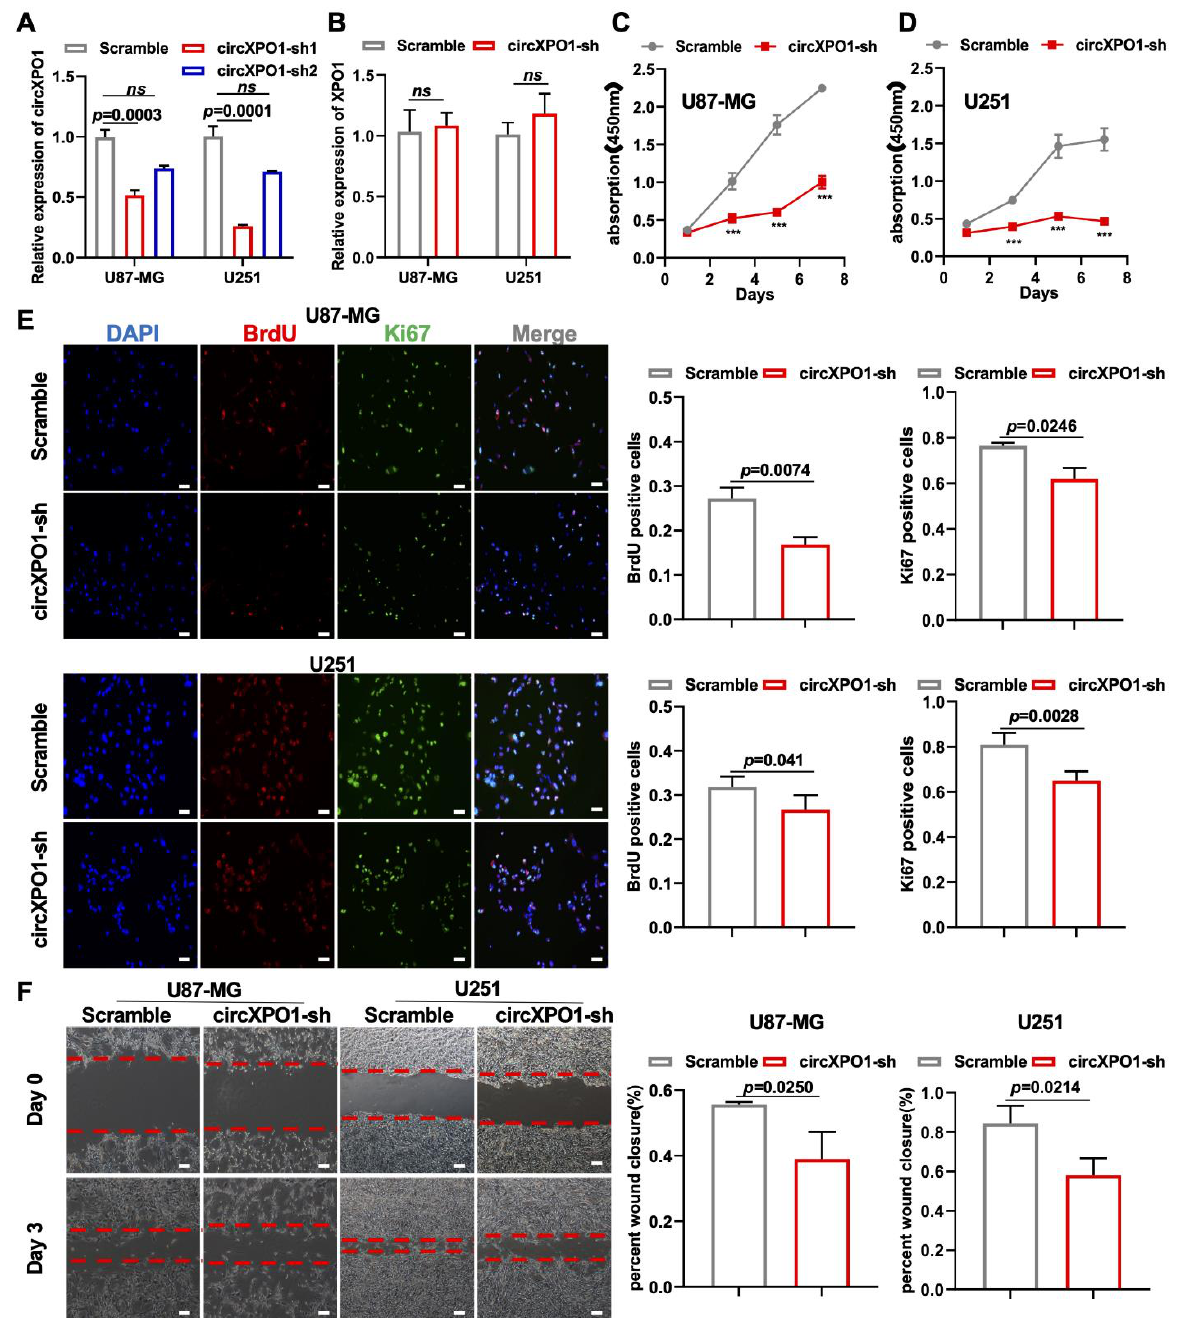
Figure 2. circXPO1 loss-of-function inhibits GBM cell proliferation and migration. ( A , B ) The efficiency and specificity of shRNA targeting circXPO1 was analyzed by qPCR after 72 h transfection in U87-MG and U251 cells. ( C , D ) Growth curves indicated glioma cell viability with or without circXPO1 knockdown by CCK-8 assays. “***” indicates p < 0.001. ( E ) Immunofluorescent staining showed the Ki67- and BrdU-positive cells in shRNA-treated U87-MG and U251 cells. The rates of BrdU- and Ki67-positive cells were calculated with ImageJ on the right side, scale bar = 100 µ m. ( F ) Effects of circXPO1 knockdown on U87-MG and U251 cell migration, scale bar = 100 μm. The wound closure was quantified by the Image J wound healing tool on the right.